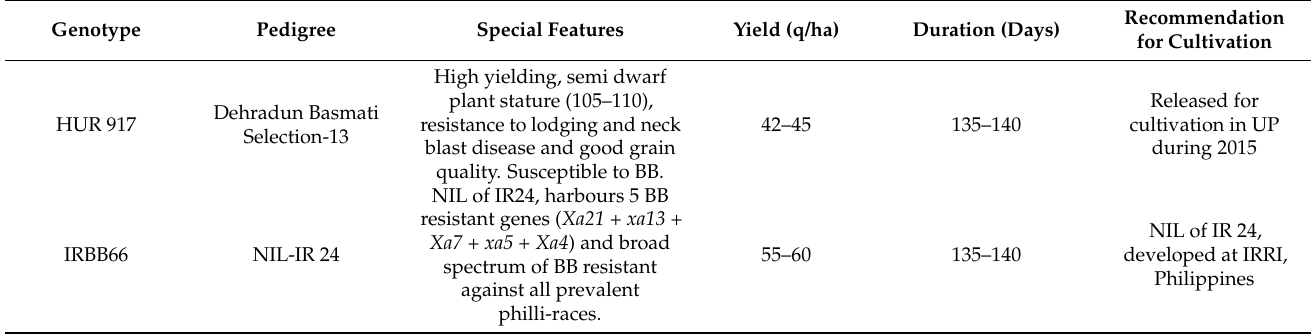
Table 1. Details of parental lines, their pedigrees, maturity duration and zone of adoption.